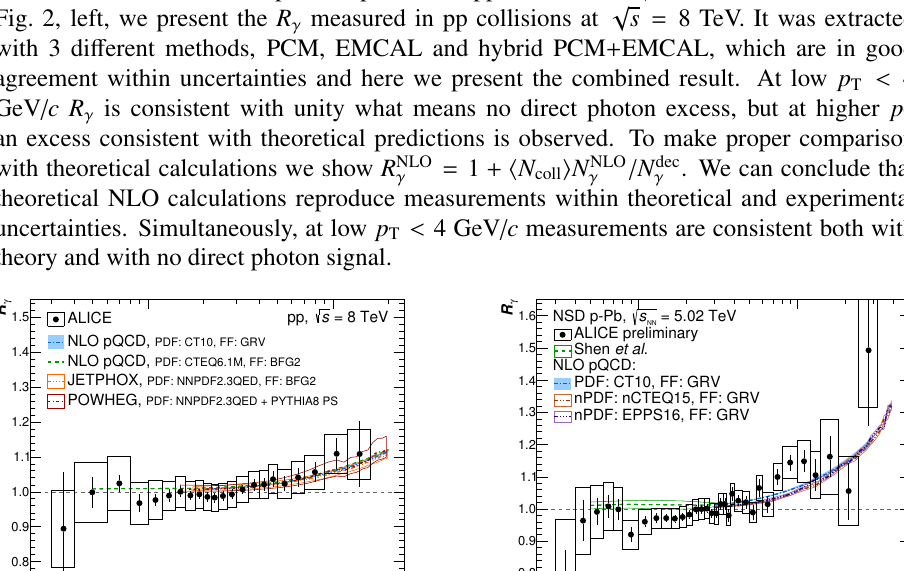
Figure 2. Left: photon double ratios R γ measured in pp collisions at √ s = 8 TeV [7]. Right: prelimi- nary results on R γ measured in p–Pb collisions at √ s NN = 5 . 02